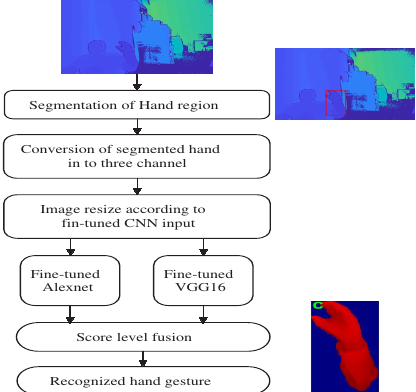
Figure 8. Flow chart for development of real-time gesture recognition